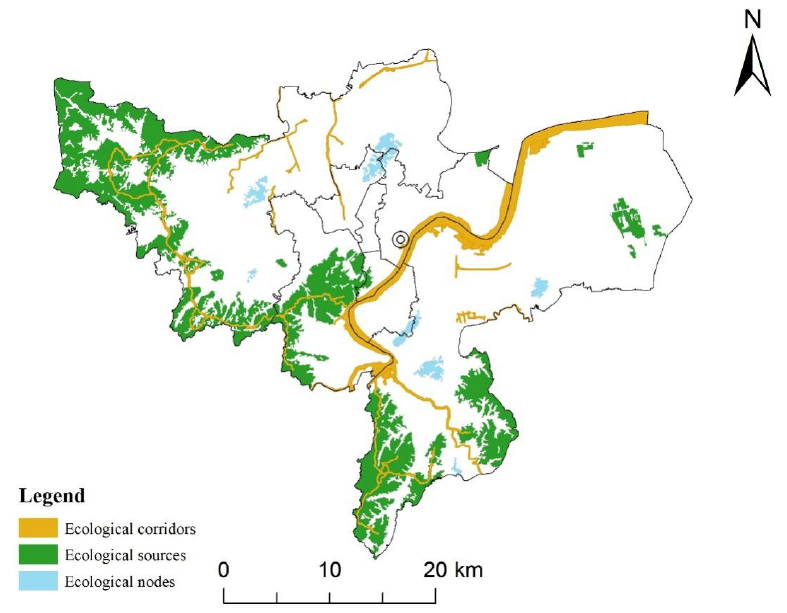
Figure 3. Spatial distribution of ecological security pattern.